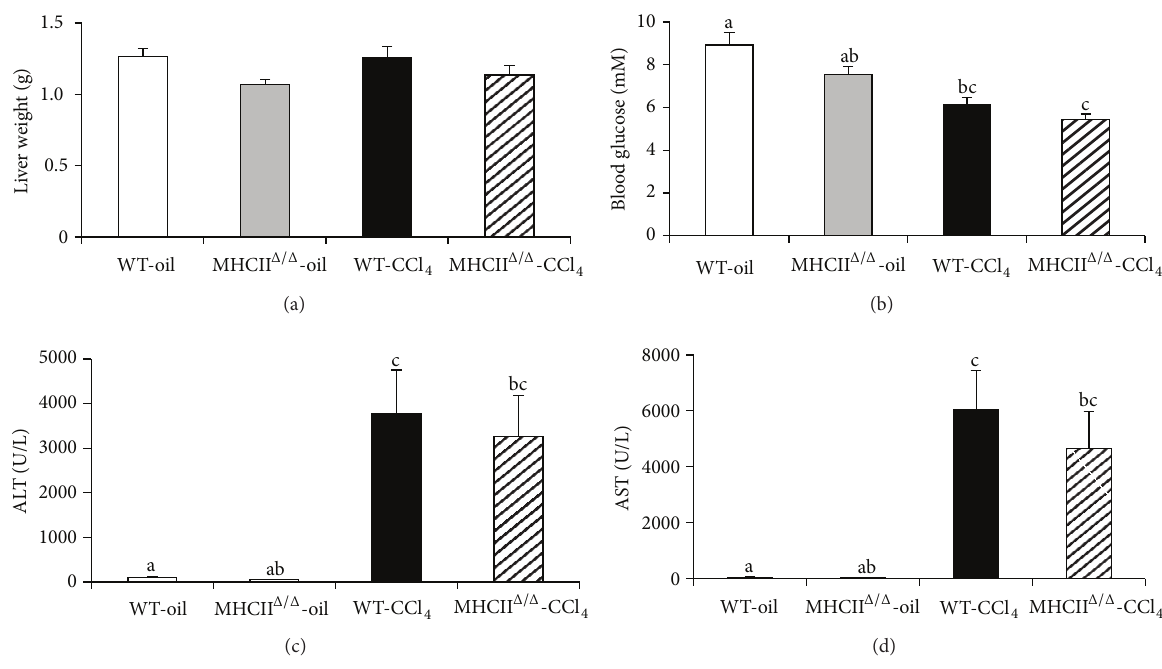
Figure 5: Effect of 4-week CCl 4 treatment on liver and blood glucose in wild-type and MHCII Δ/Δ mice. Open bars represent oil-treated wild-type (WT-oil), closed bars CCl 4 -treated wild-type (WT-CCl 4 ), gray bars oil-treated MHCII Δ/Δ mice, and semiclosed bars CCl 4 -treated MHCII Δ/Δ mice (wild-type oil: 𝑛 = 7 , MHCII Δ/Δ oil: 𝑛 = 5 , wild-type CCl 4 : 𝑛 = 11 , MHCII Δ/Δ CCl 4 : 𝑛 = 9 ). Data are presented as mean ± SEM. (a) Liver weight. (b) Fasting blood glucose decreased after the CCl 4 treatment in both groups. (c), (d) Strong increase in fasting plasma ALT and AST was observed after the CCl 4 treatment. a , b , c 𝑃 < 0.05 , ANOVA and Tukey Kramer HSD test. Different letters indicate the significant difference between